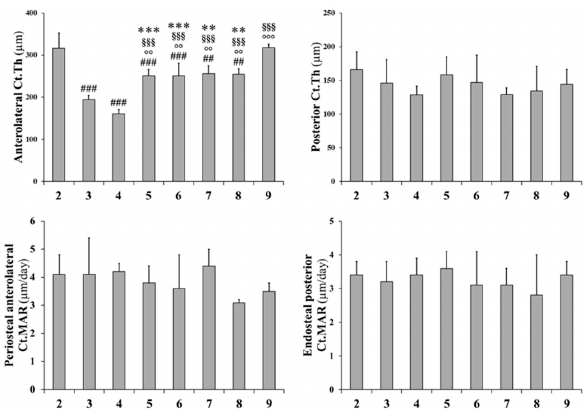
Figure 5. Static and dynamic histomorphometric parameters of cortical bone in L5 vertebral body sections. Ct.Th: cortical bone thickness; Ct.MAR: cortical mineral apposition rate. Values are